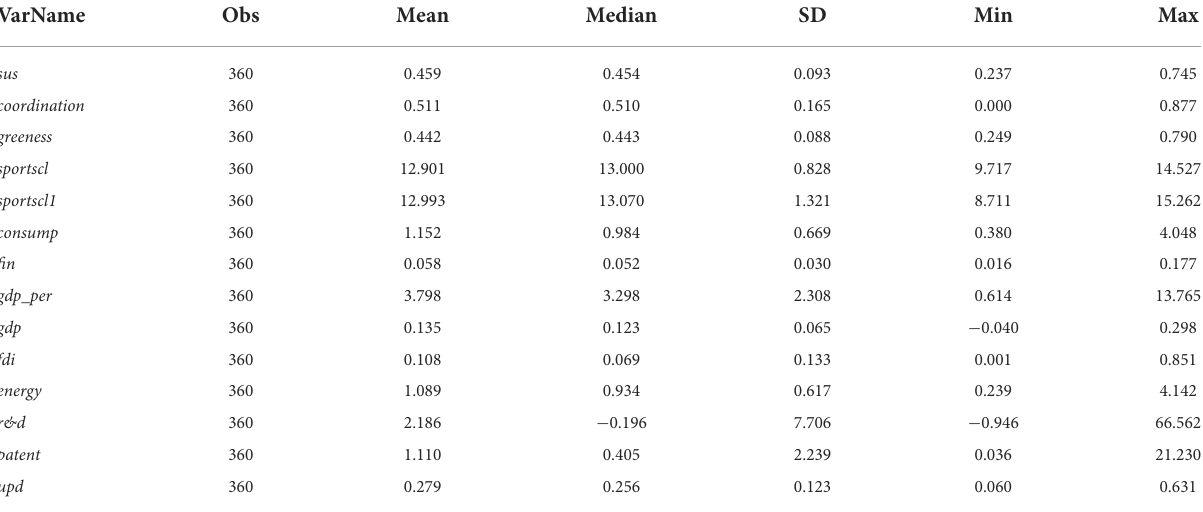
TABLE 2 Descriptive statistics for the